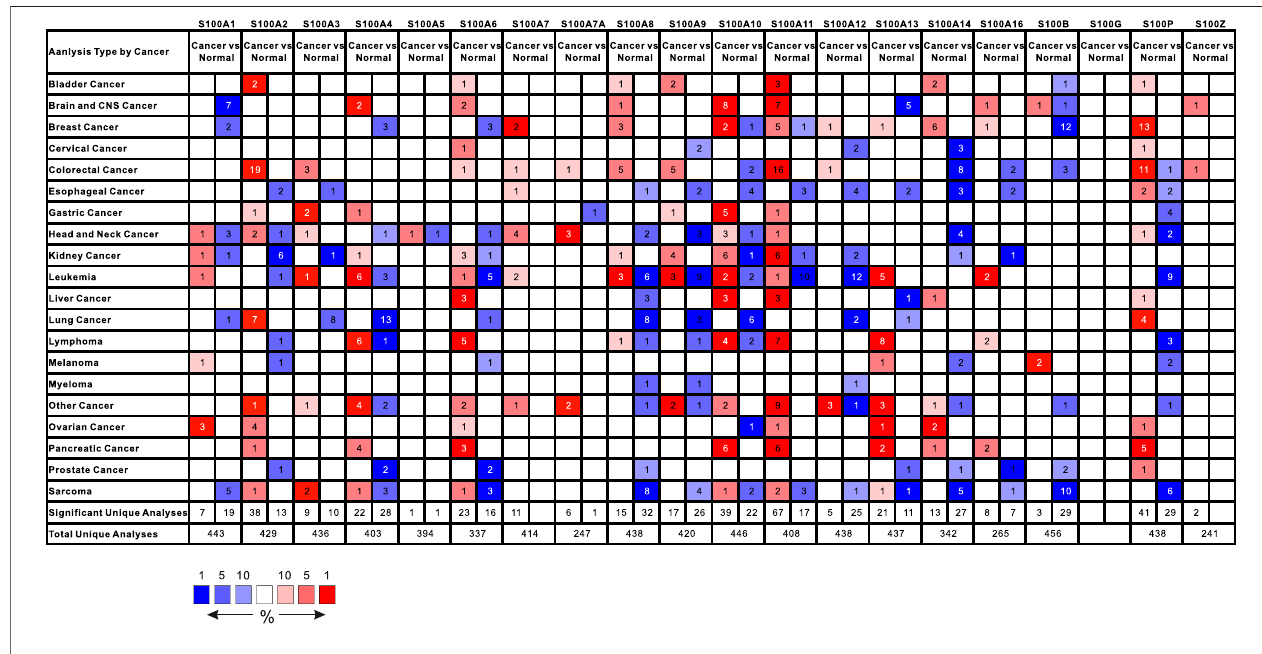
FIGURE 1 | The mRNA expression of the S100 family members (S100s) in 20 different cancer types using ONCOMINE. Color was determined by the best gene rank percentile gene for analyses within the cell; blue represented down-expression and red represented over-expression. The numbers in colored cells represents the quantities of datasets which satis fi es the threshold: gene rank percentile (10%), P-value (0.001), and fold change (2.0). The mRNA expression of S100A2/A4/A6/A10/ A11/A13/14/A16/P were higher in tumor than in normal pancreatic